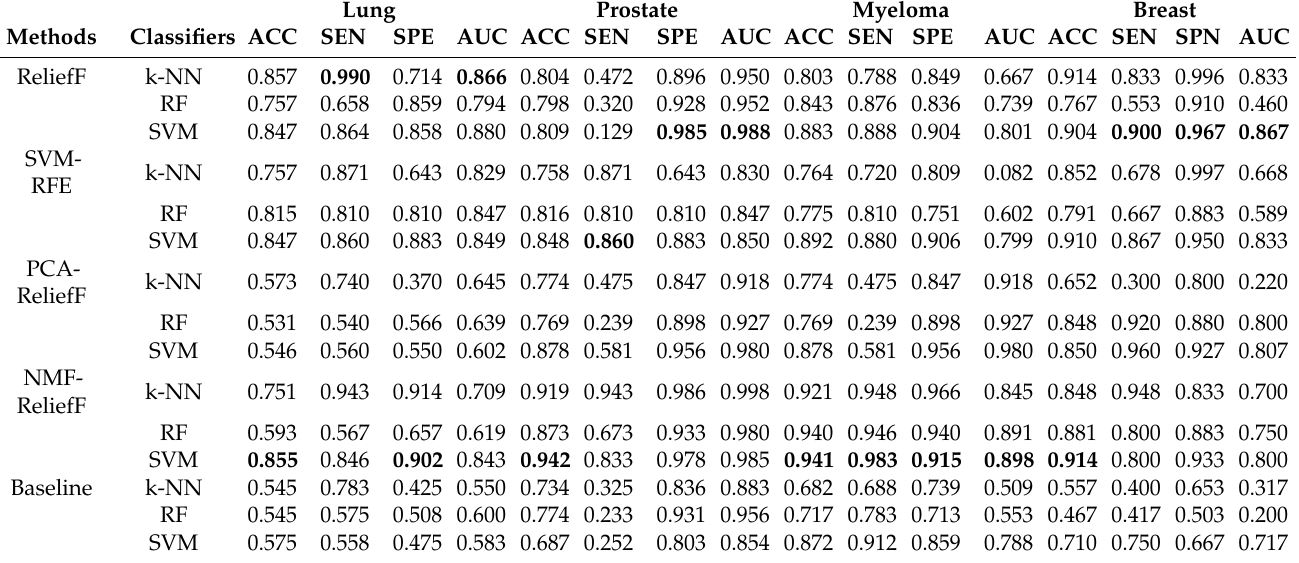
Table 2. Comparison of our method, ReliefF, SVM-RFE and PCA-ReliefF on high-dimensional microarray data sets; the best result is in bold